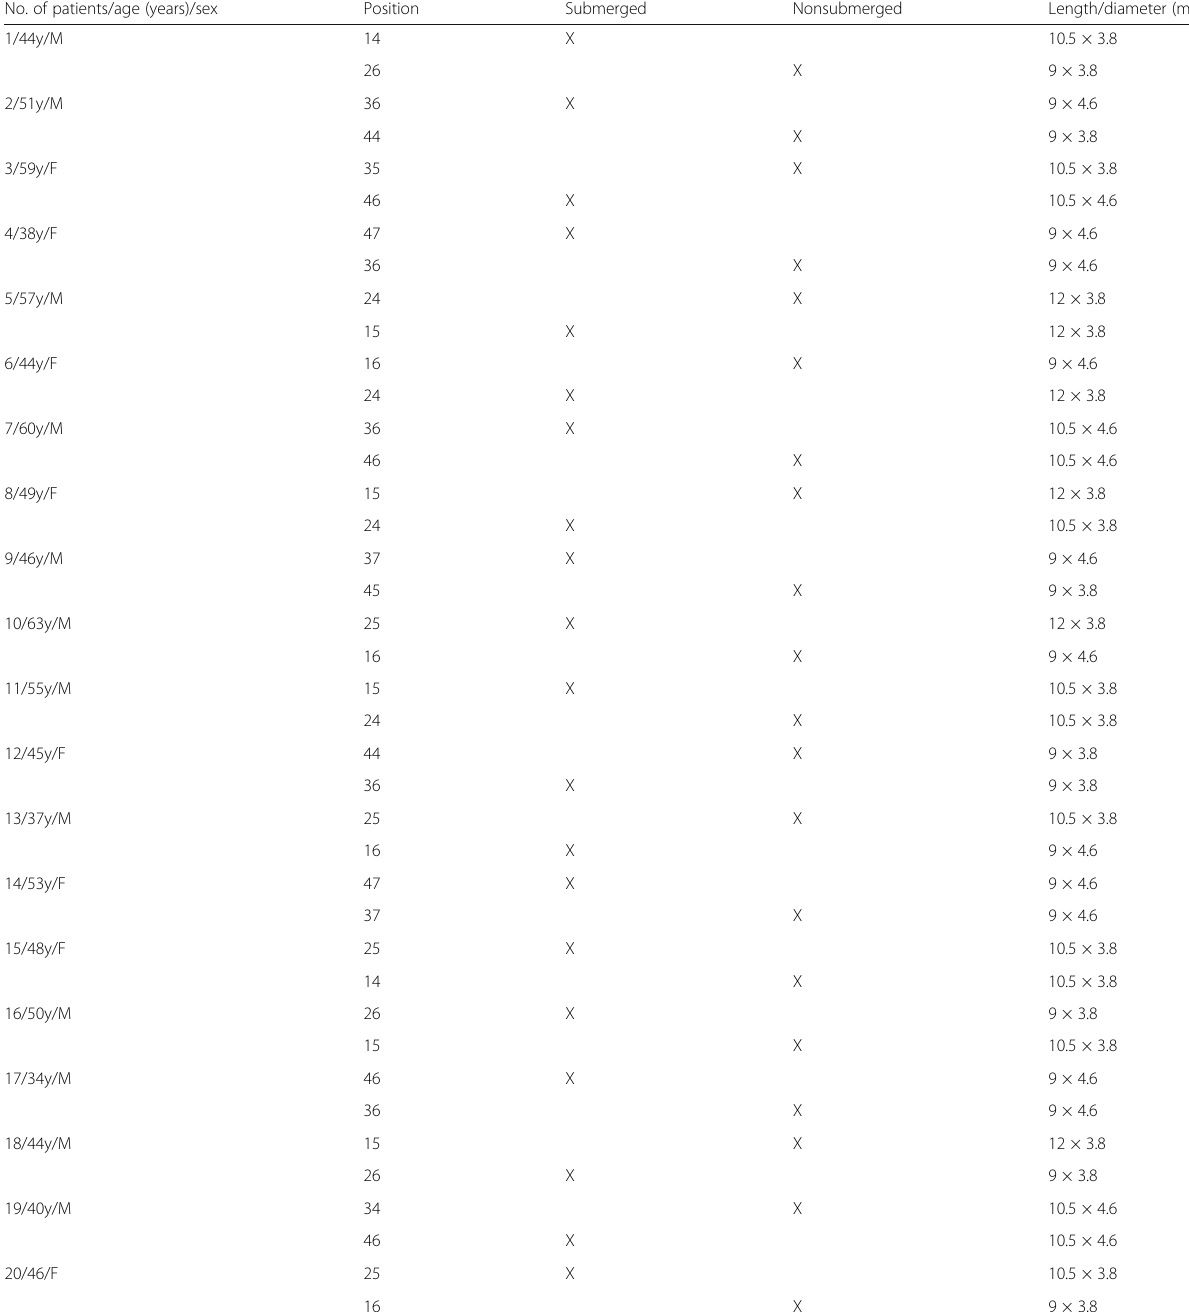
Table 1 Demographic data of patients, implants position, and type of implant No. of patients/age (years)/sex